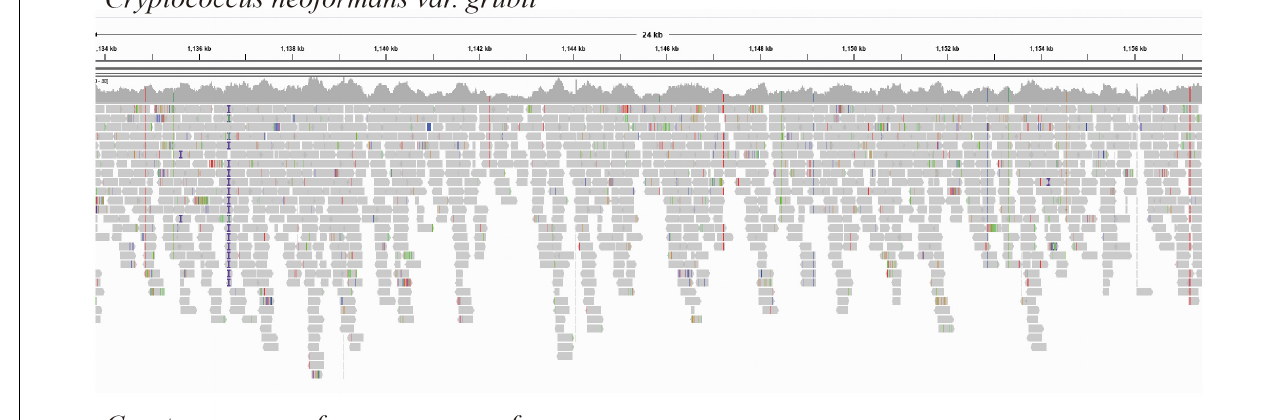
protocol and version-3 600-cycle kit. The quality of the